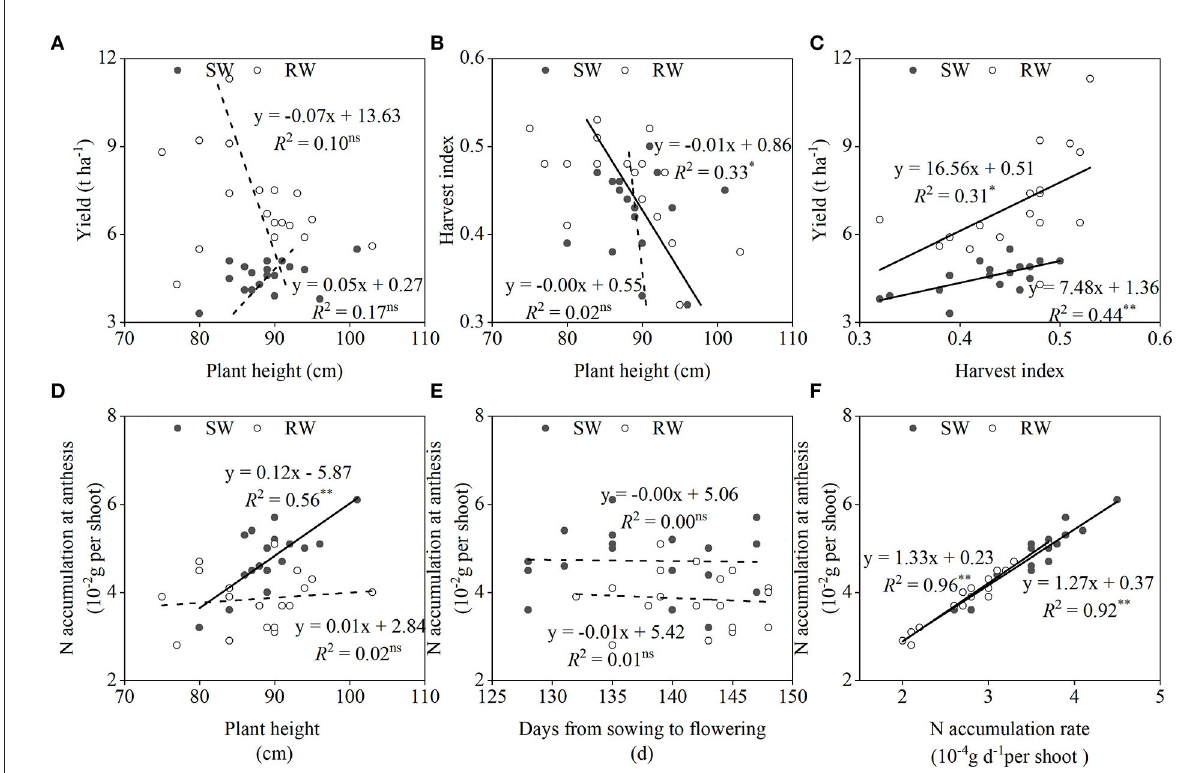
FIGURE7 Relationships between yield and NUpE (A) , NUtE (B) ; between NUpE and N accumulation at maturity (C) , fertile spikes (D) ; between NUtE and post-anthesis N uptake (E) , N remobilization efficiency (F) in two wheat cropping systems. All values were measured with three replications ( n = 3), two-year data were pooled. SW, soybean-wheat cropping system; RW, rice-wheat cropping system; N, nitrogen; NUpE, N uptake efficiency; NUtE, N utilization efficiency. ns represents non-significant at P > 0.05, while * and ** represent significant at P < 0.05 and P < 0.01 from ANOVA, respectively. Solid and dashed lines indicate significant and insignificant differences at P < 0.05 and P > 0.05,